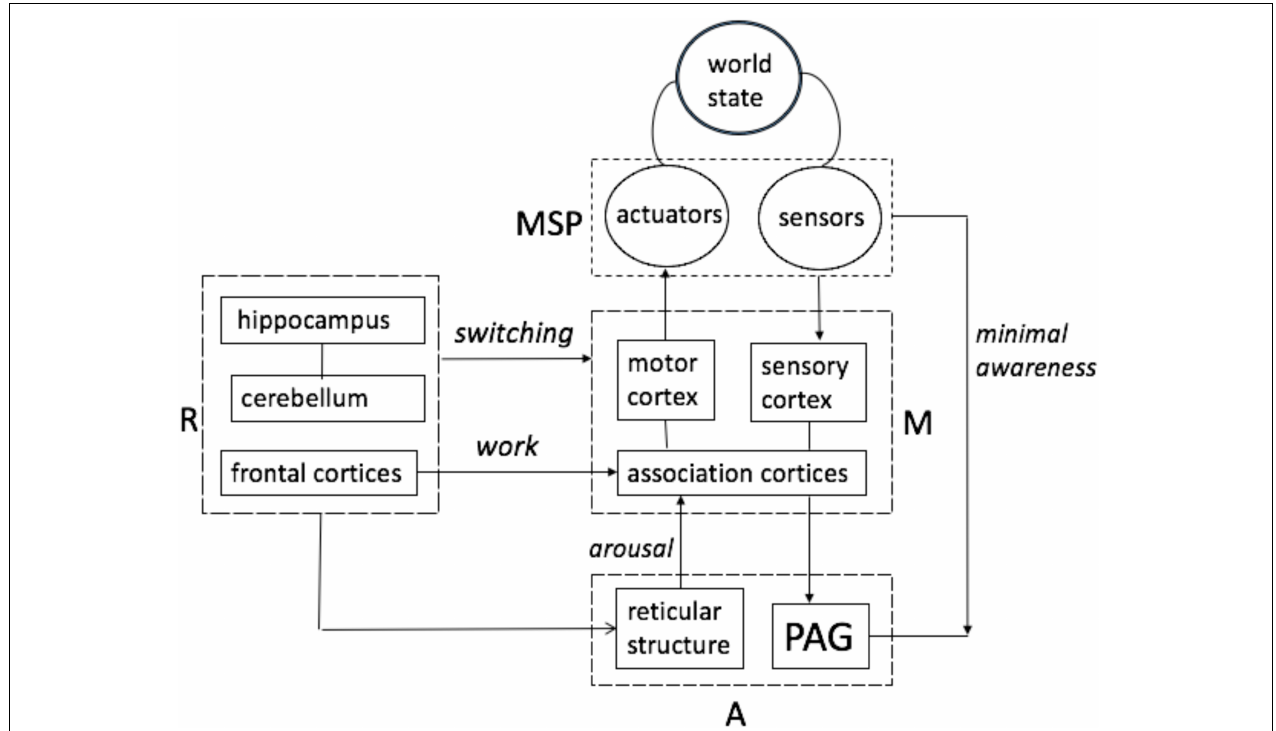
FIGURE 2 | Mental models are structures formed in Memory System (M) and manipulated by Regulatory System (R). Manipulation is enabled by activation (arousal) arriving from the Activation System A (includes Reticular Activating System) and serves to organize activities in Motor-Sensory Periphery (MSP) in such a way that the resulting changes in world states are consistent with the intent originating in